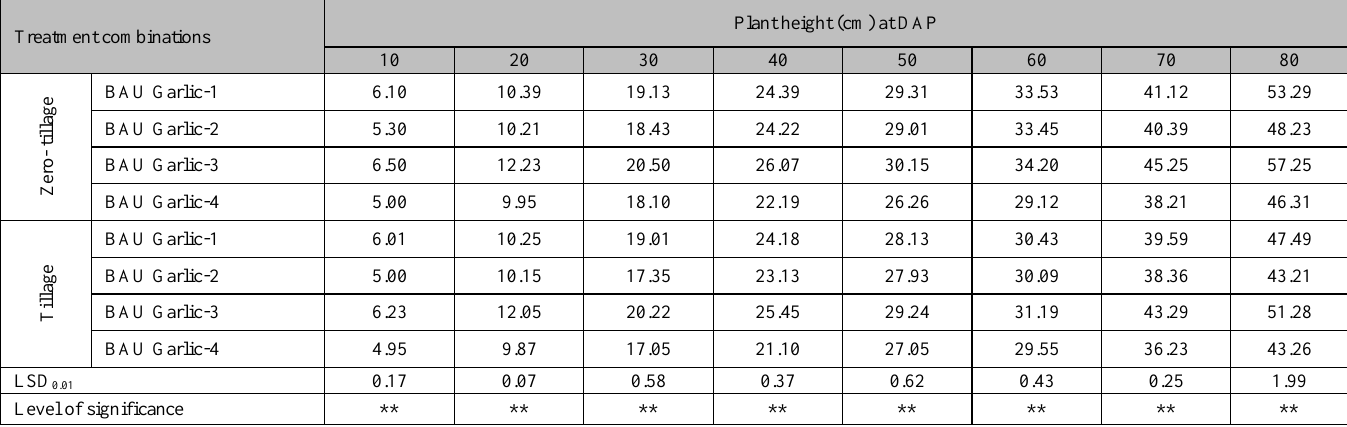
Figure 2 . Effects of planting system (a) and variety (b) on number of leaves of garlic at different days after planting. Vertical bars indicate LSD at 1% level of significance. Table 1. Combined effects of planting system and variety on plant height of garlic at different days after planting